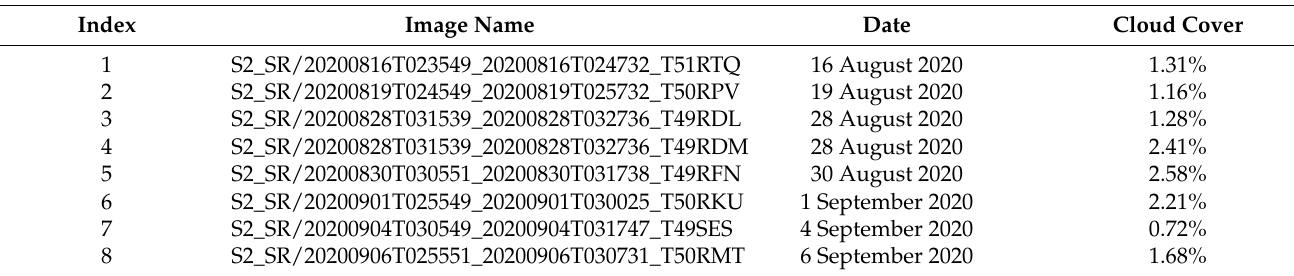
Table 1. Detailed information of Sentinel-2 images.